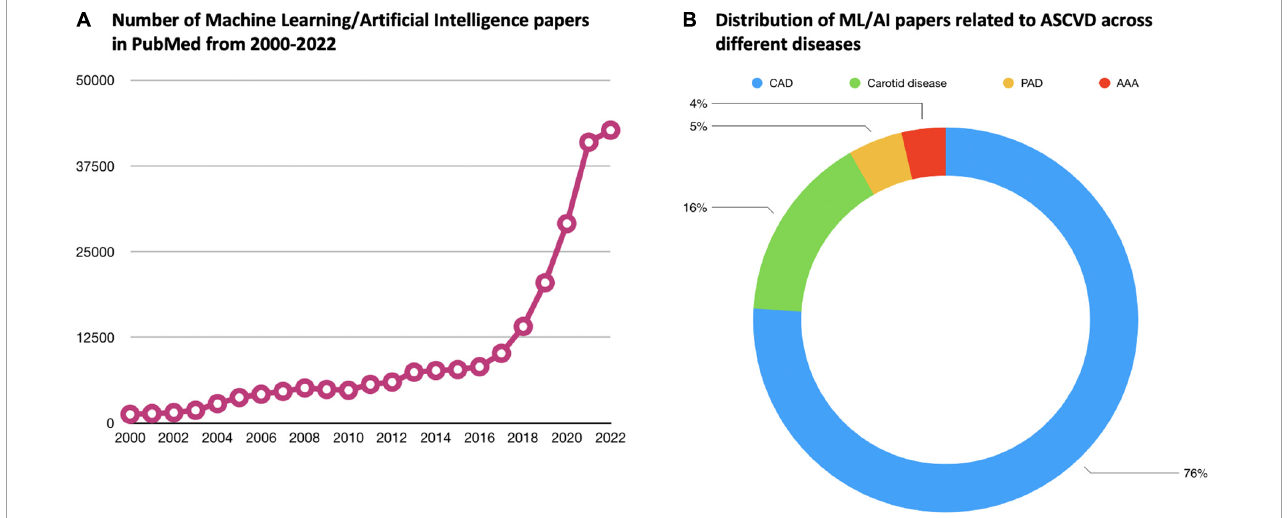
FIGURE2 Current body of evidence related to ML/AI in the field of ASCVD. (A) Demonstrates how the number of papers in PubMed related to ML/AI has increased dramatically over the past two decades. (B) Shows how the ML/AI papers related to ASCVD specifically are distributed across the different diseases under the umbrella of ASCVD. In PubMed, the vast majority of ASCVD ML/AI papers are related to CAD. ML, machine learning; AI, atherosclerosis artificial intelligence; ASCVD, atherosclerotic cardiovascular disease; CAD, coronary artery disease; PAD, peripheral artery disease; AAA, abdominal aortic